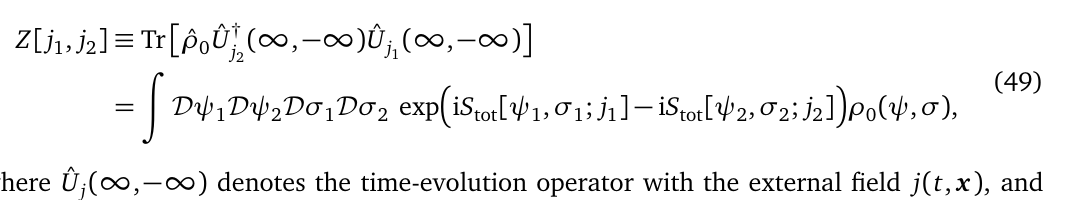
Figure 4: (Left) An open system realized through the interaction with the environ- ment. (Right) Closed time contour in the Schwinger-Keldysh formalism. erating functional is defined by putting the system in the presence of the different background ( a = 1,2 ) for the forward and backward time evolutions as (see the right panel fields j a